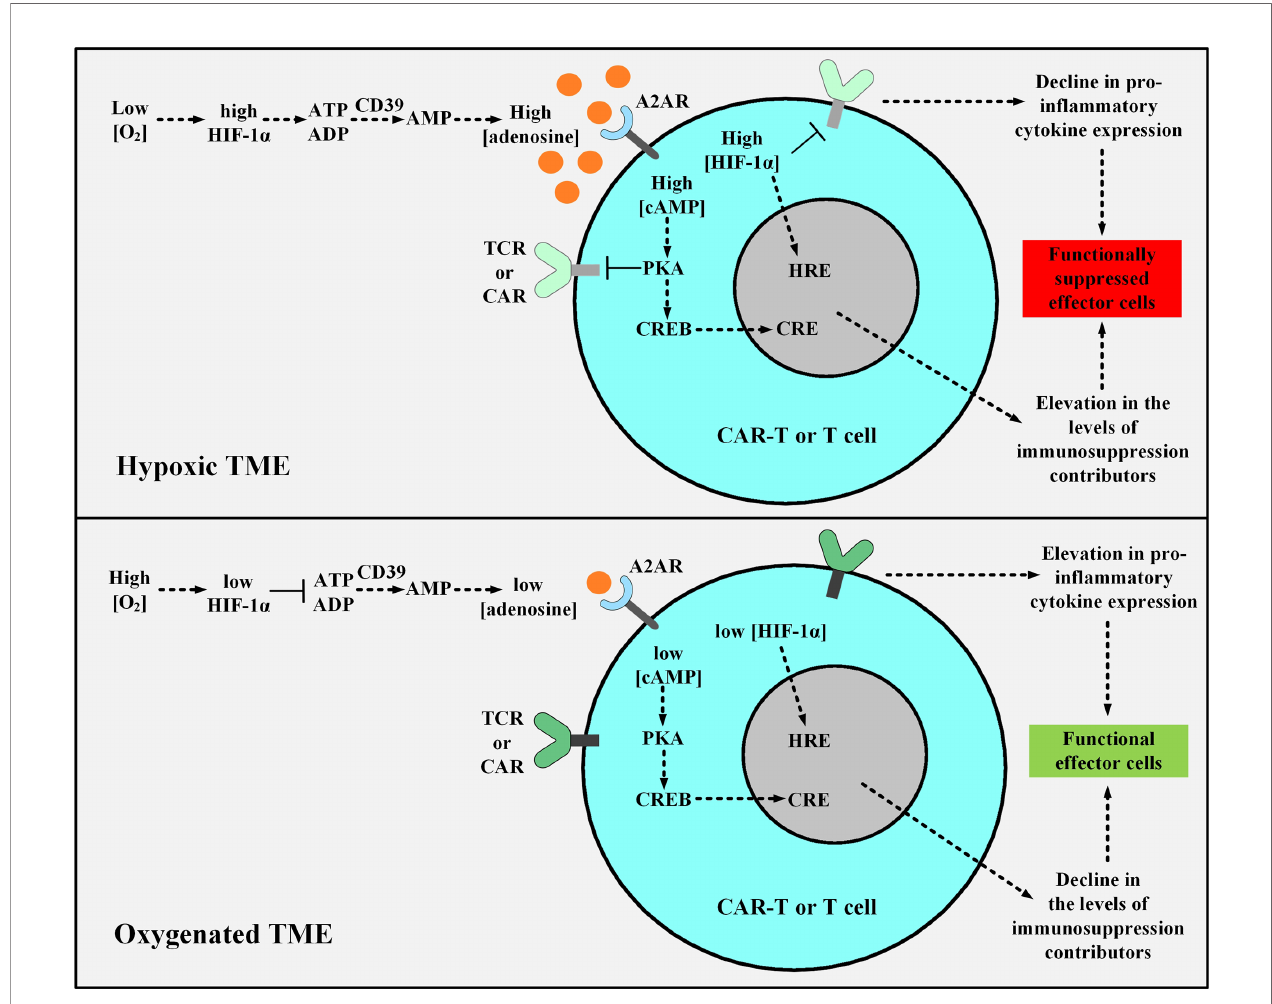
FIGURE 7 | The effects of hypoxic or oxygenated TME on the fate, functionality, and antitumor activity of T cell or CAR T cells. The upper panel shows the hypoxic TME. In this condition, the low level of O 2 leads to the stabilization of HIF-1 a which elevates the expression level of CD39 and CD73 leading to the excessive production of adenosine. Adenosine binds to A2AR causing an elevation in the level of cAMP, and cAMP activates PKA. Further on, PKA inhibits TCR and CAR signaling and upregulates the expression of immunosuppresion contributors via CRE. Moreover, HIF-1 a elevates the expression level of immunosuppressive genes through HRE. The activated CRE and HRE signaling cascades together reduce the level of INF- g , IL-12, and IL-2 expression and upregulate TGF- b , IL-10, PD-1, CTLA-4, COX-2, and Treg expression. In the lower panel, supplemental oxygenation or using oxygenation agents elevates the level of O 2 , therefore, the downstream signaling pathway cannot proceed as it would in the case of a hypoxic microenvironment. TME, tumor microenvironment; HIF-1 a , Hypoxia-inducible factor-1 a ; A2AR, A2A adenosine receptor; PKA, protein kinase A; CRE, cAMP Response Element; CREB, cAMP Response Element-Binding Protein; HRE, Hypoxia Response Element; TCR, T cell receptor; CAR, chimeric antigen